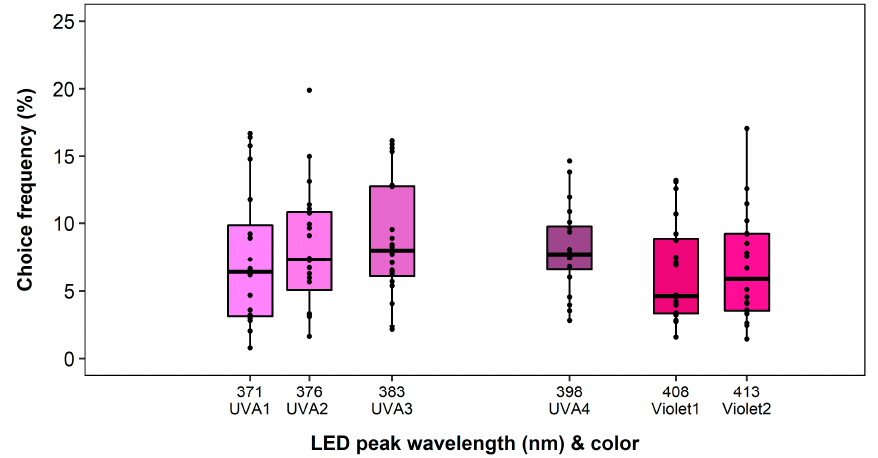
Figure 7. Wavelength preferences of Frankliniella occidentalis in multiple-choice experiment with light-emitting diodes (LEDs) in the ultraviolet and violet spectral range. See Table 1 and Figure 2 for LED specifications. No significant differences were observed (generalized linear model, p < 0.05, n = 20).